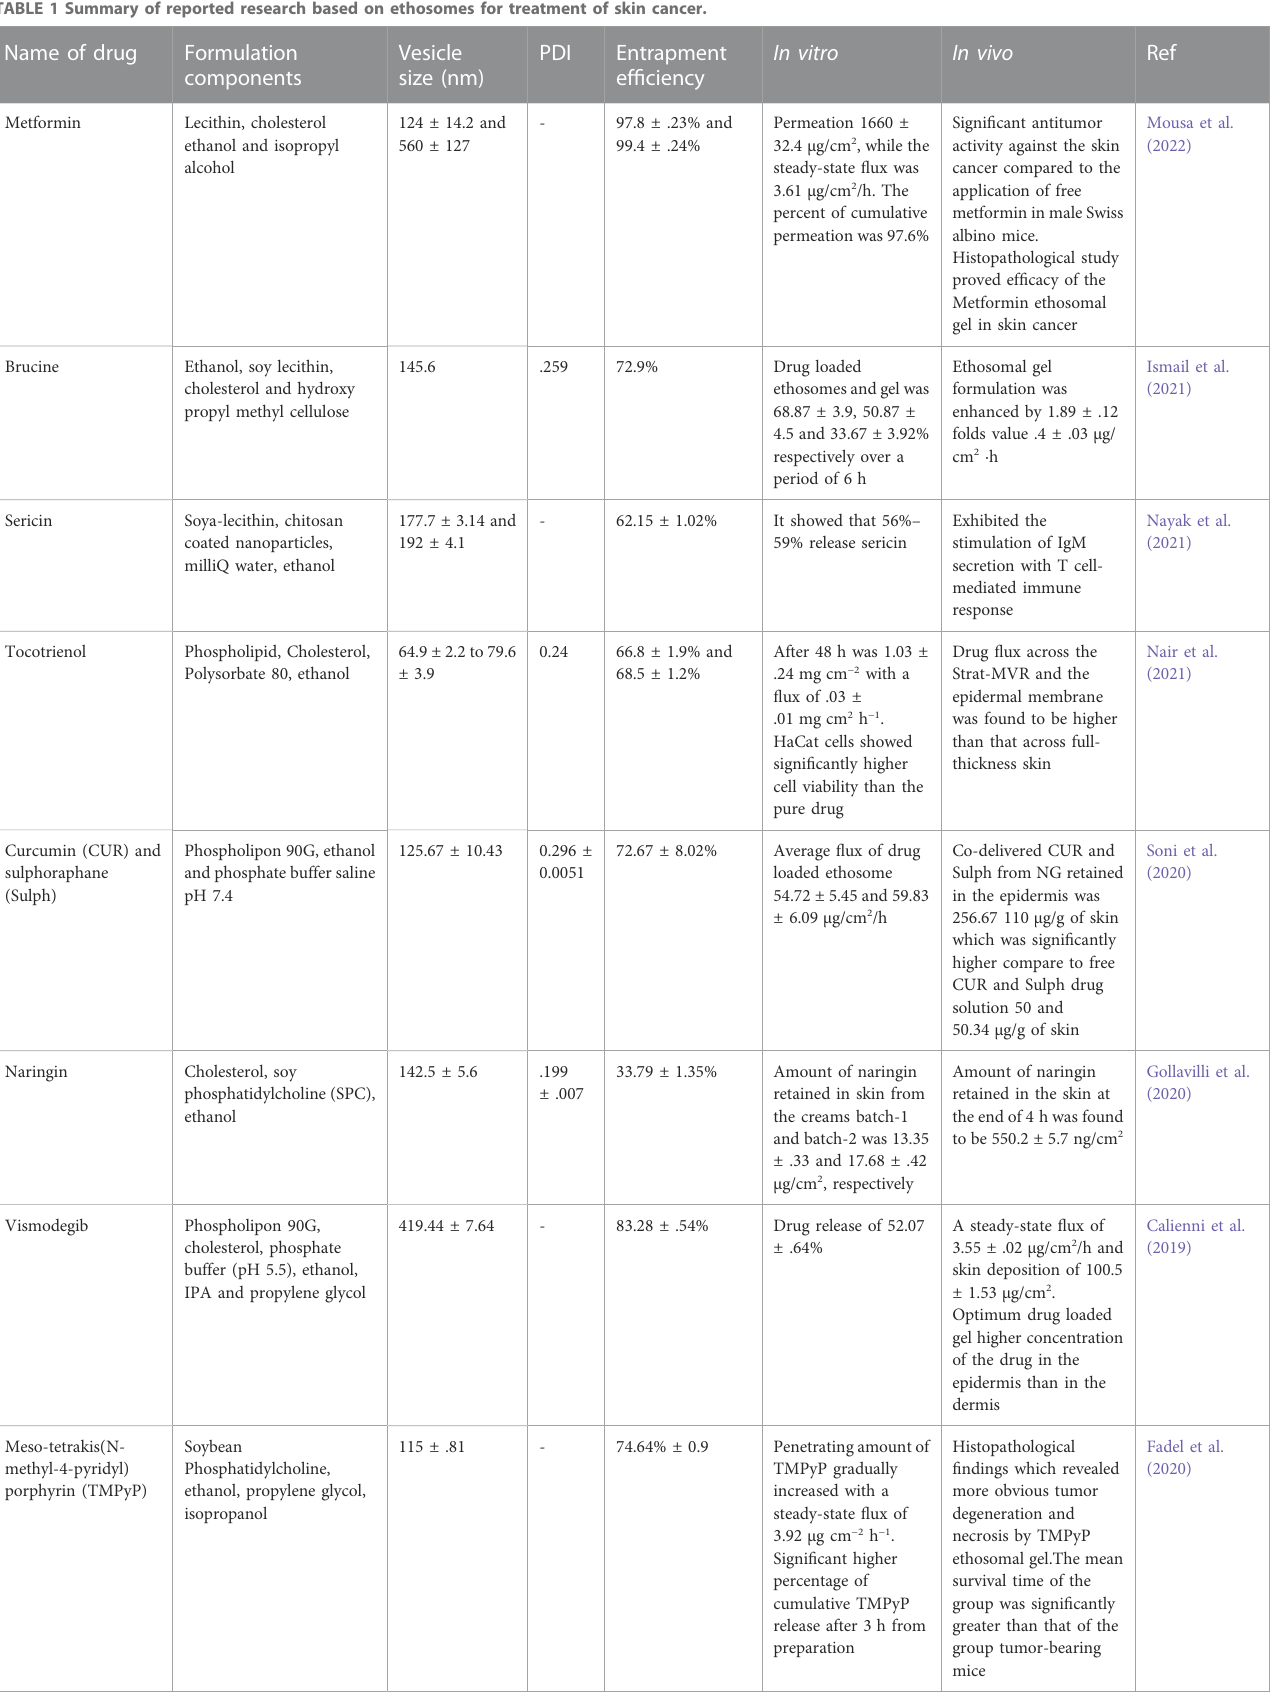
TABLE 1 Summary of reported research based on ethosomes for treatment of skin cancer. Name of